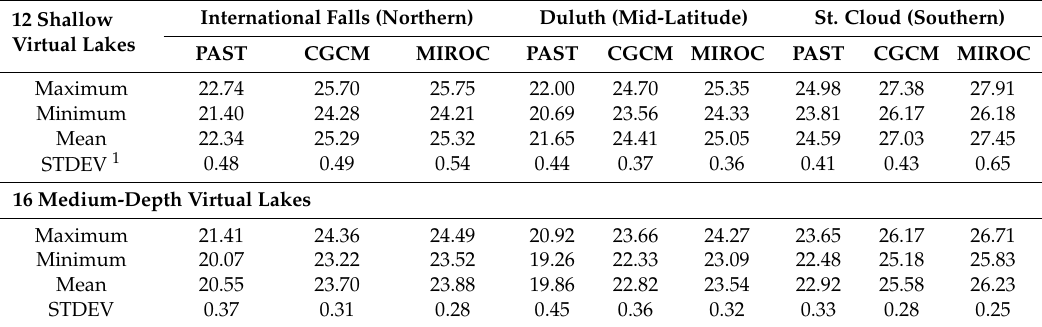
Table 4. Statistics of AvgATDO3 VB ( ◦ C) under the past climate conditions (1962–2008) and the future Simulations and analysis were made with weather data input from weather stations in International Falls, Duluth, and St. Cloud.